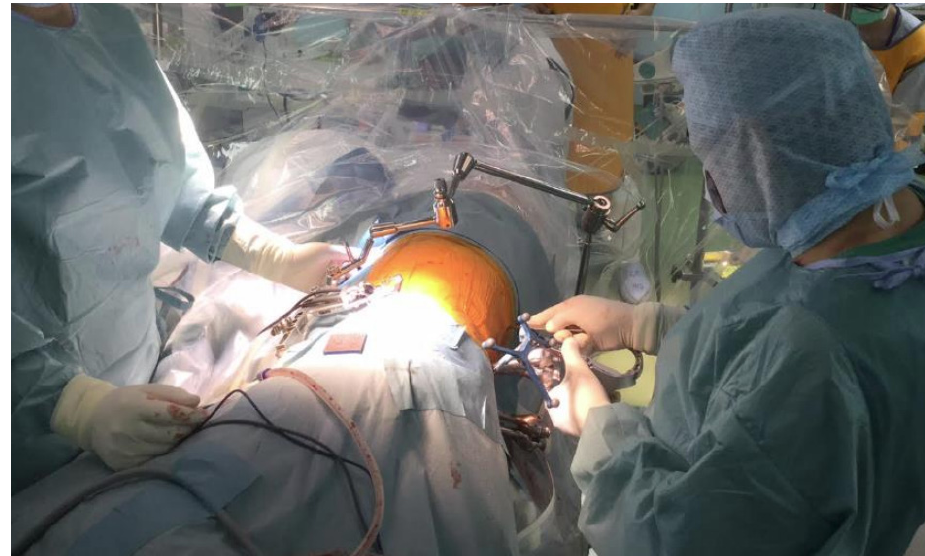
Figure 1. Intraoperative picture showing two surgeons operating simultaneously. The patient is in the right lateral position. The main surgeon is shown at the left, while on the right the assistant surgeon is applying a rod percutaneously.